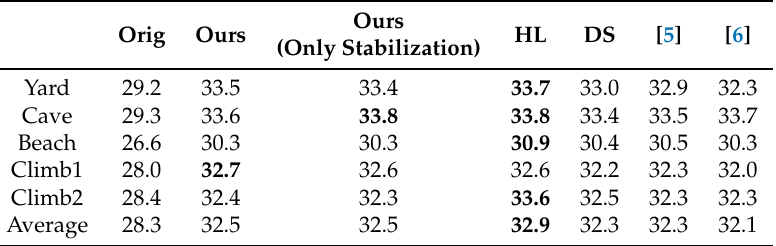
Table 5. Revised ITF